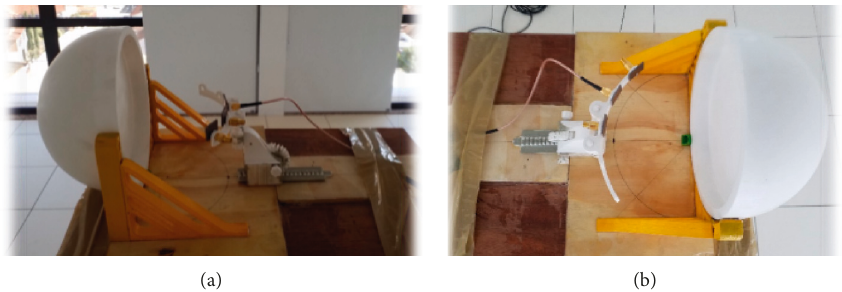
Figure 8: Ultra-wideband dielectric lens antennas for beamsteering system prototype. (a) Side view. (b) Upper view.